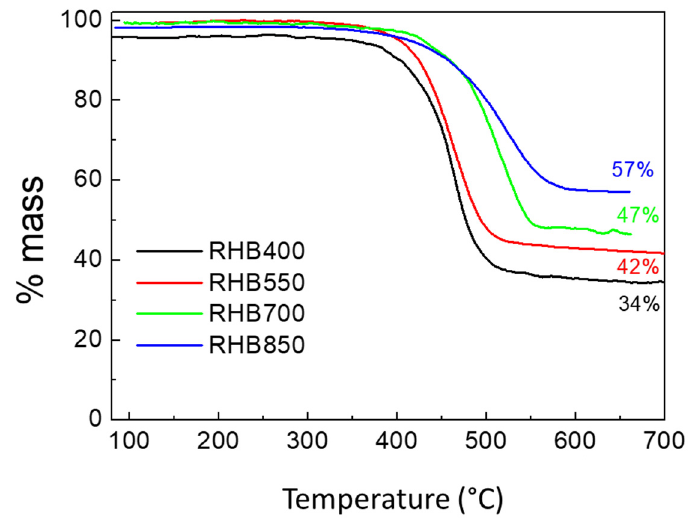
Figure 5. Thermogravimetric analysis (TGA) curves, under air atmosphere for the biochars stud-